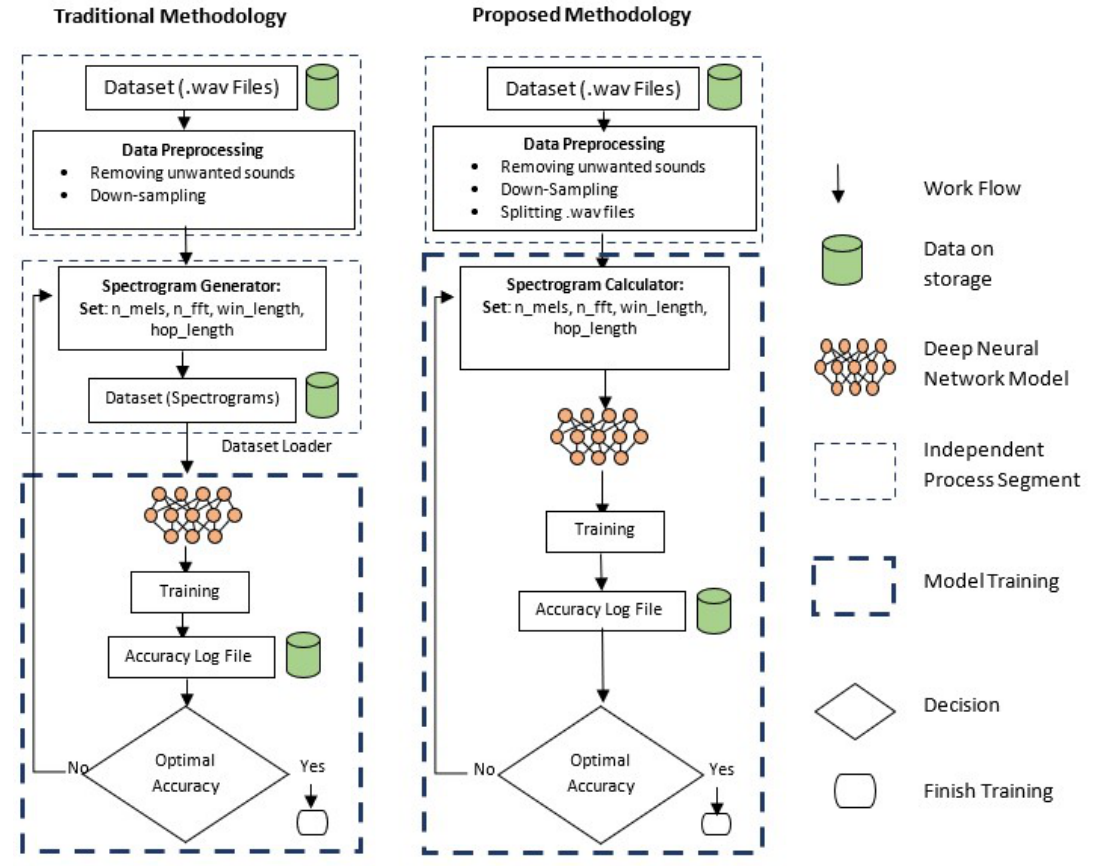
Figure 2. Proposed methodology in contrast with traditional acoustic-based research